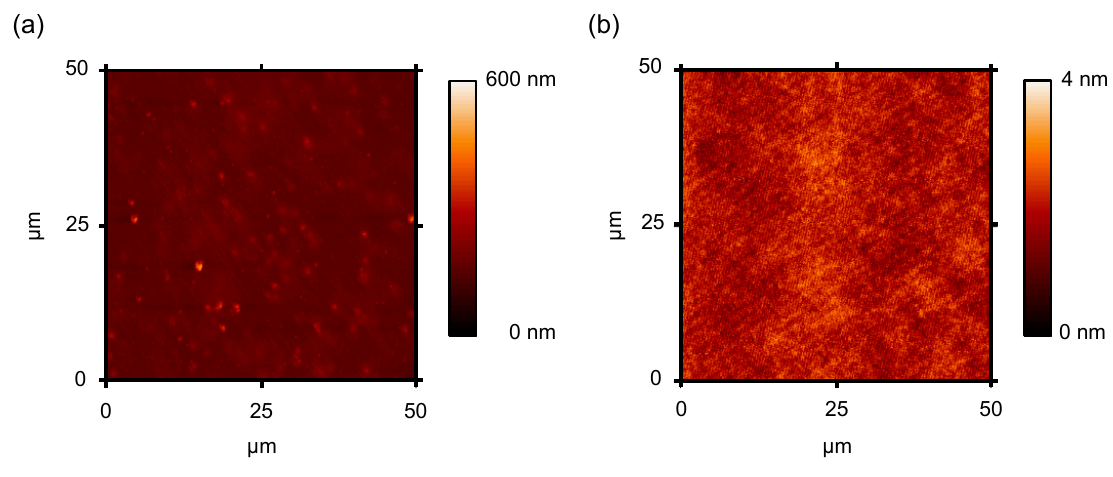
Figure 1. ( a ) AFM pictures of cleaned polyethylene naphtalate (PEN) and ( b ) SU-8 planarized PEN substrates using foil-on-carrier (FOC)